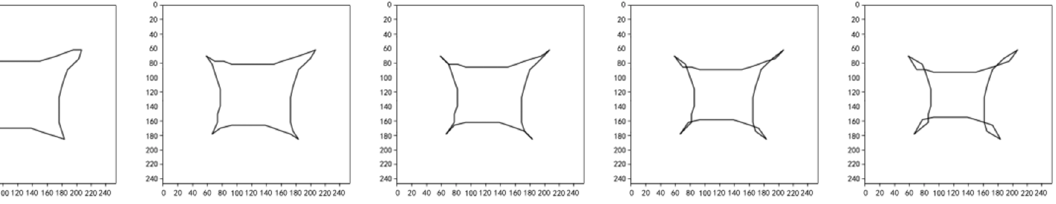
Figure 10. Change process of the dynamic feature graphic for box-shape graphic.